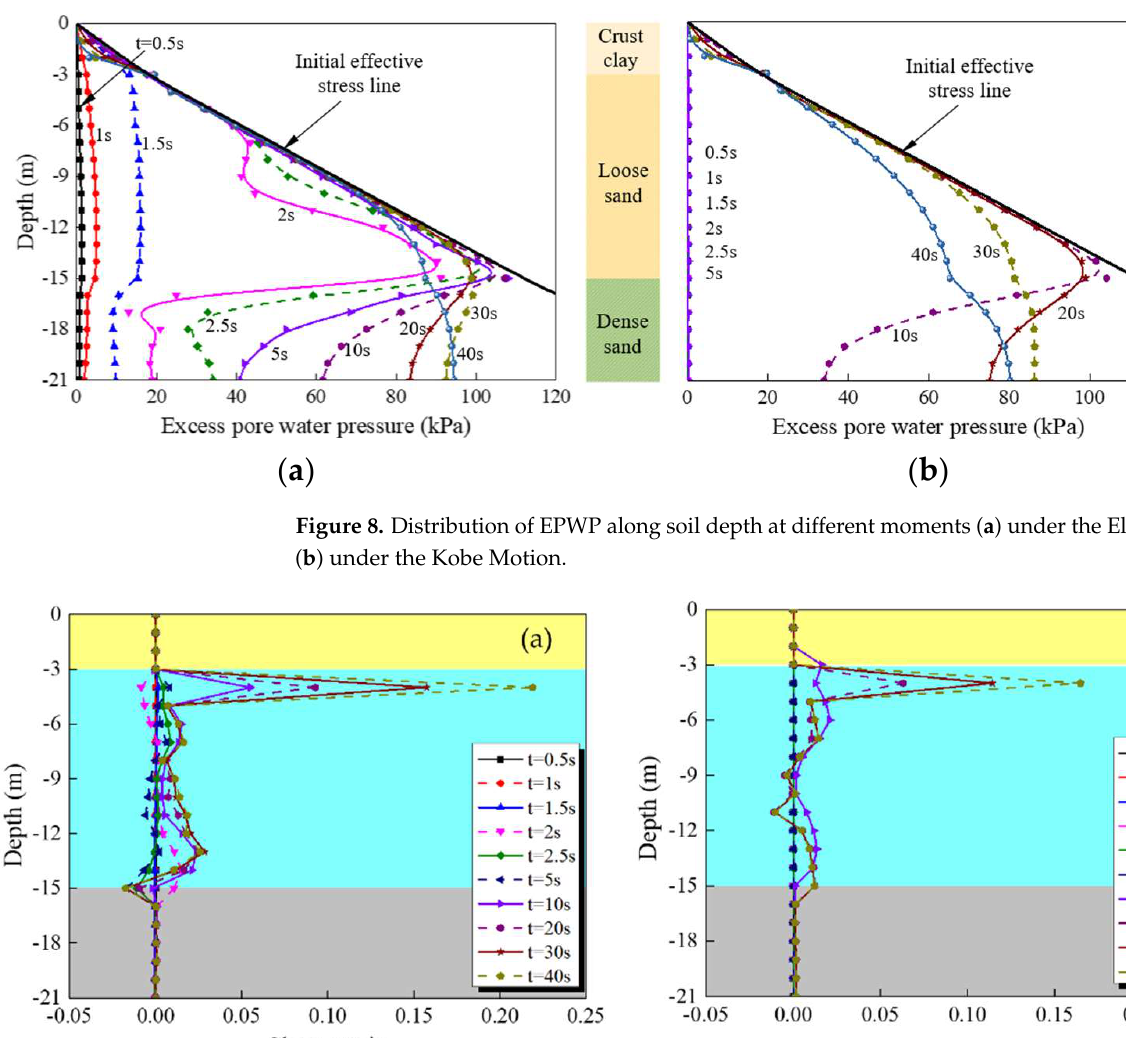
Figure 9. Distribution of shear strain along soil depth at different moments ( a ) under the El-Centro motion; ( b ) under the Kobe Motion.